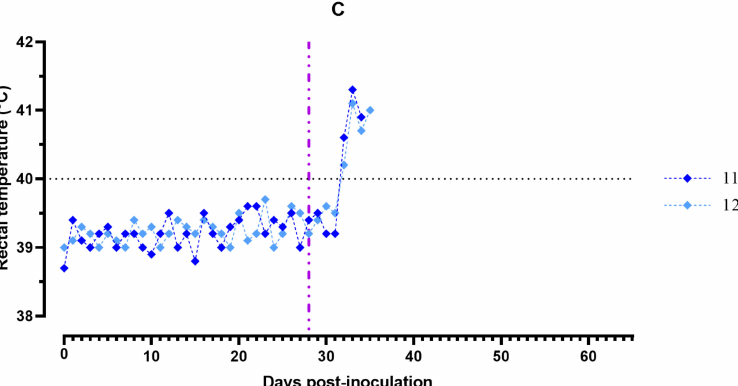
Figure 1. Kinetics of pig’s body temperature: ( A ) group #1 after inoculation with the ASFV-Katanga- 350 and challenge on the 28th day with the ASFV-Stavropol 01/08; ( B ) group #2 after two inoculations with the ASFV-Katanga-350 and challenge on the 28th day with the ASFV-Stavropol 01/08; ( C ) group #3 after challenge with the ASFV-Stavropol 01/08. Each curve represents an individual animal’s values. Vertical dashed lines: green—days of inoculation of ASFV-Katanga-350, purple—challenge by the ASFV–Stavropol